Question: Condense the content of this figure into a single sentence.
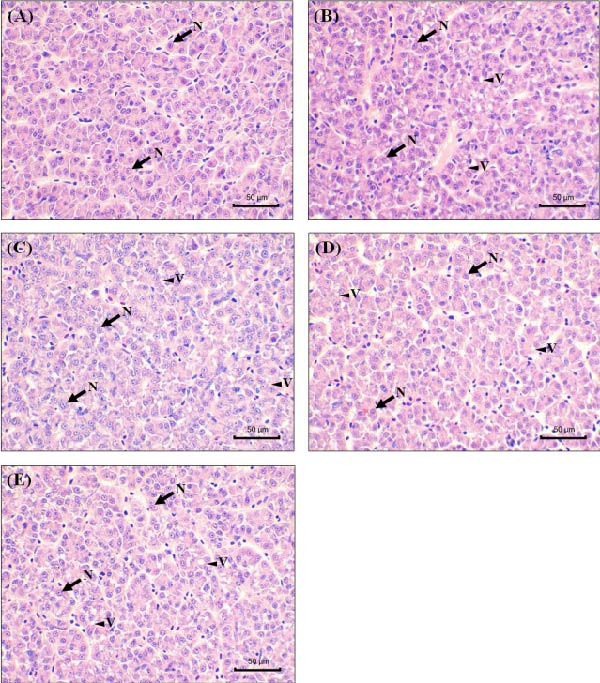
Answer: Liver morphology of rainbow trout ( Oncorhynchus mykiss ) fed experimental diets replacing soybean meal with graded levels of A. bisporus (AB) and P. ostreatus (PO) meals for 60 days. (A–E) Hematoxylin and eosin (H&E) stain, (A) CTRL, (B) AB25, (C) AB50, (D) PO25, (E) PO50. (N, arrow) hepatocytes nuclei, (V, arrowhead) hepatocyte cytoplasmic vacuole. Scale bar 50 μm. Dietary treatments: CTRL (control diet), AB25 (25% SBM replacement), AB50 (50% SBM replacement), PO25 (25% SBM replacement), and PO50 (50% SBM replacement).